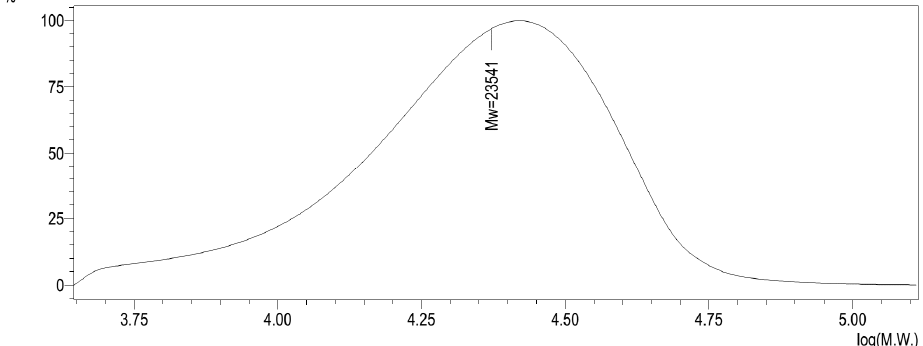
Figure 1. GPC traces of PVI were used to obtain nanocomposites.